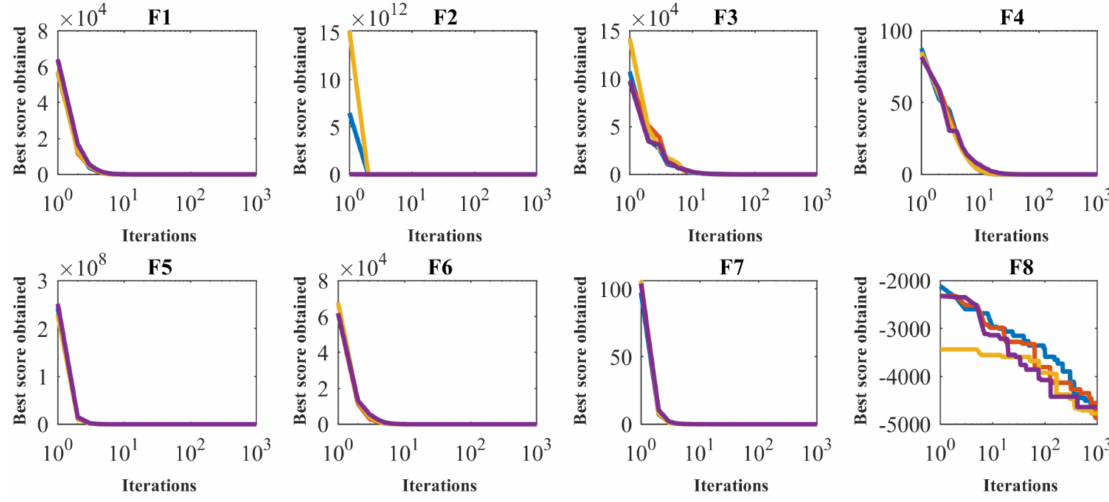
Figure 4. Sensitivity analysis of SLOA for number of population members.